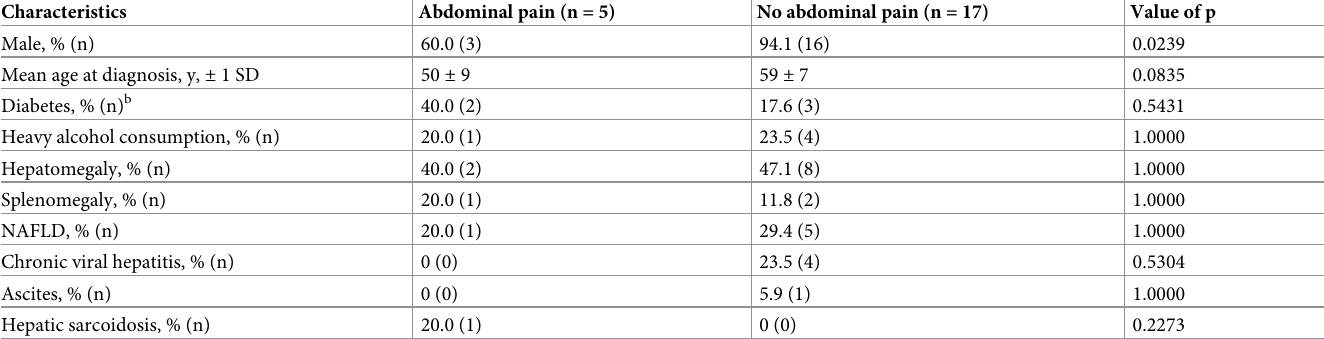
The proportion of men was significantly greater among probands with than probands without cirrhosis (Table 1). Mean age of probands with cirrhosis was significantly greater than that of probands without cirrhosis (Table 1). The respective prevalences of heavy alcohol consump- tion, abdominal pain, abdominal tenderness, hepatomegaly, splenomegaly, and chronic viral hepatitis were significantly greater in probands with than without cirrhosis. Median TS, SF, and QFe values were significantly greater in probands with than without cirrhosis (Table 1). Among 22 probands with cirrhosis, the proportion of men was significantly lower in those with than without abdominal pain, although the prevalence of co-morbid conditions in pro- bands with cirrhosis with and without abdominal pain did not differ significantly (Table 2). Table 2. Hemochromatosis probands with HFE p.C282Y homozygosity and cirrhosis a .